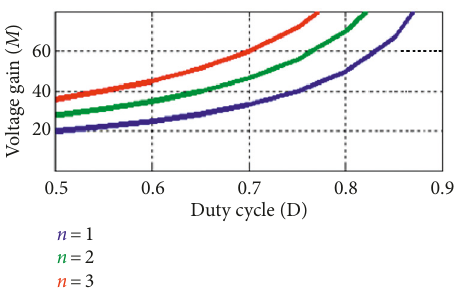
Figure 6: Normalized voltage stresses (NVS) of the circuit